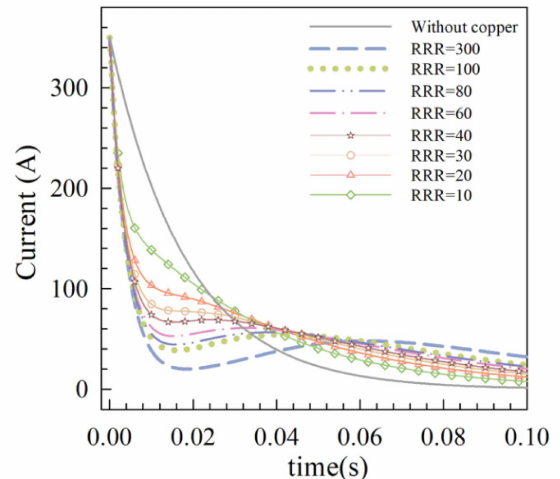
Figure 10. Current of the coil with different copper discs during fast discharging tests. Rd is 1 Ω . The initial transport current is 350